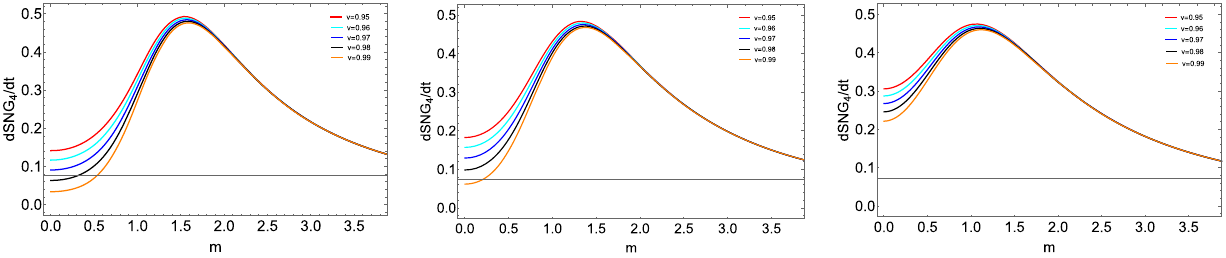
Fig. 8 Action growth v.s. graviton mass for massive AdS 4 black hole with m 0 = 2. From left to right, the horizon curvature is k = − 1, k = 0 and k = 1, respectively